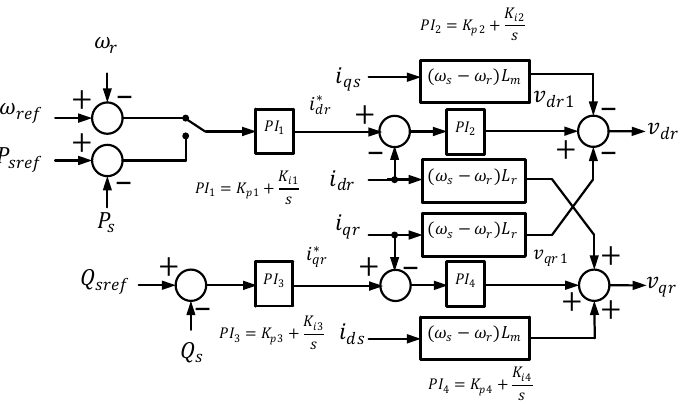
Figure 6. Rotor ‐ side converter controller block. Figure 6. Rotor-side converter controller